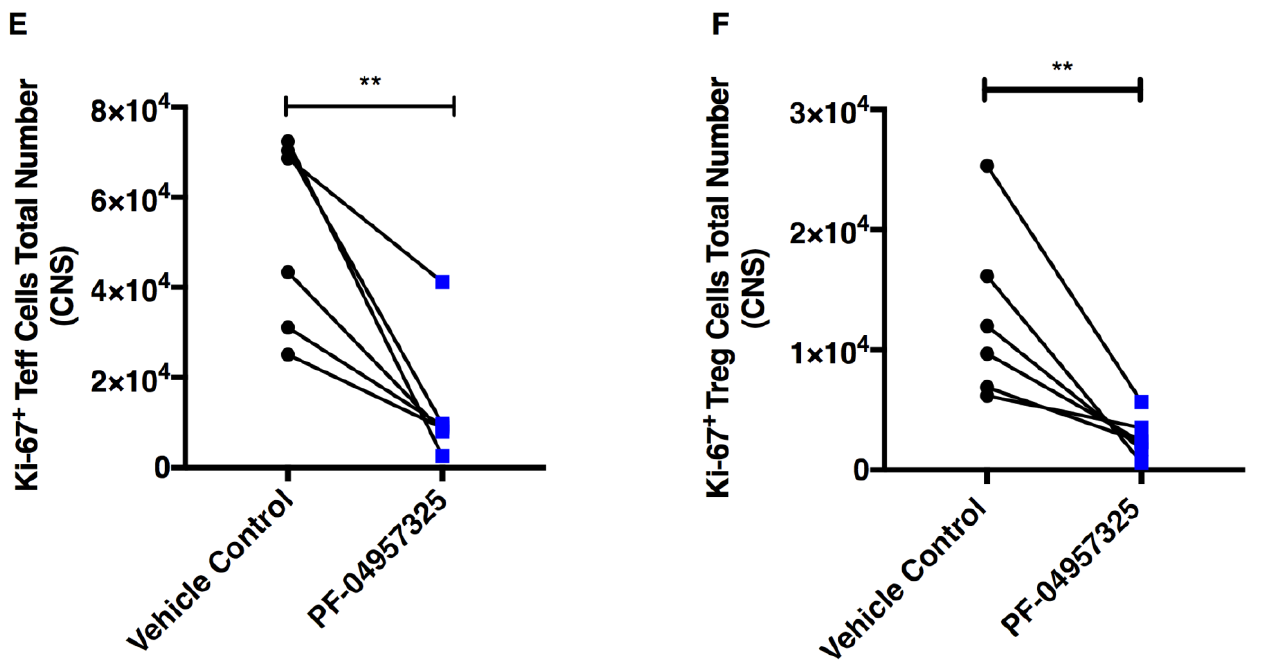
Figure 5. Treatment with PF-04957325 suppresses the accumulation of activated and proliferating Teff and Treg cell subpopulations in the spinal cord. Mice with EAE scores of at least 1 were treated with the vehicle control or PF-04957325 thrice daily for 6 to 13 days. The data represent the total number of Foxp3 − / α L + Teff cells (* p = 0.046) ( A ), Foxp3 + / α L + Treg cells (* p = 0.014) ( B ) ( n = four mice per group, mean ± SEM of four independent experiments), Foxp3 − /CD44 + Teff cells (** p = 0.006) ( C ), Foxp3 + /CD44 + Treg cells (** p = 0.008) ( D ), Foxp3 − /Ki-67 + Teff cells (** p = 0.0040) ( E ) and Foxp3 + /Ki-67 + Treg cells (** p = 0.008) ( F ) ( n = 6 mice per group, mean ± SEM of four independent experiments) in the spinal cord (CNS), analyzed by flow cytometry.